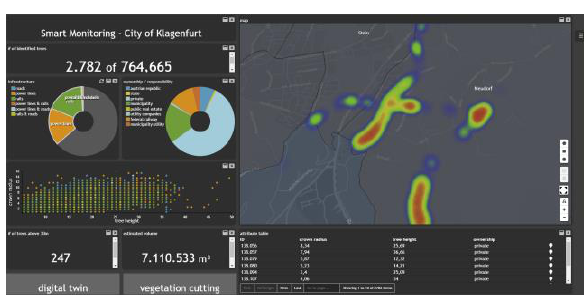
Figure 16: Dashboard for Smart Monitoring of trees close